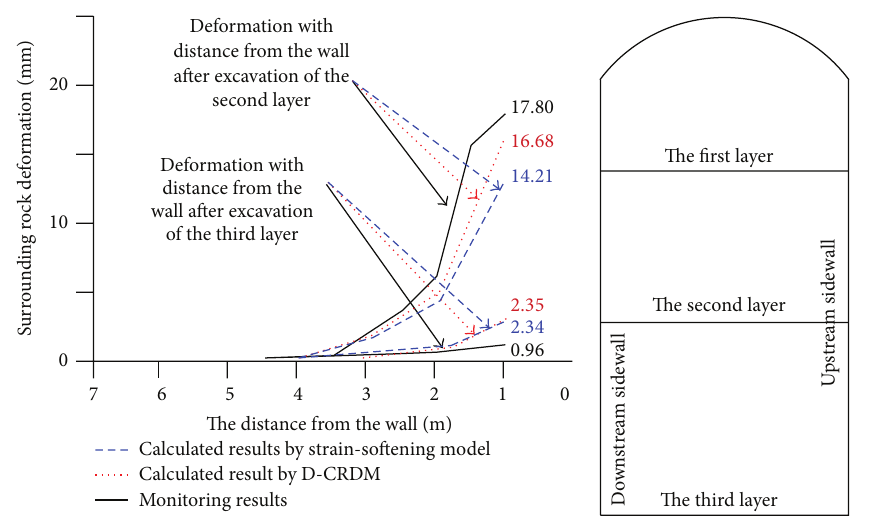
Figure 6: Surrounding rock deformation and rock mass